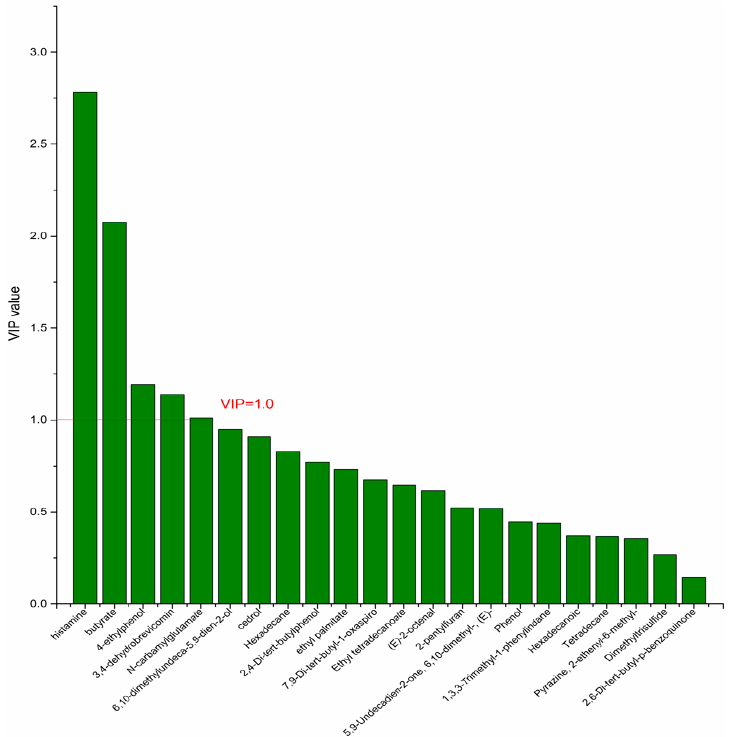
Figure 12. The VIP plot of the differential bacterial metabolites in DPA group vs. MC group.